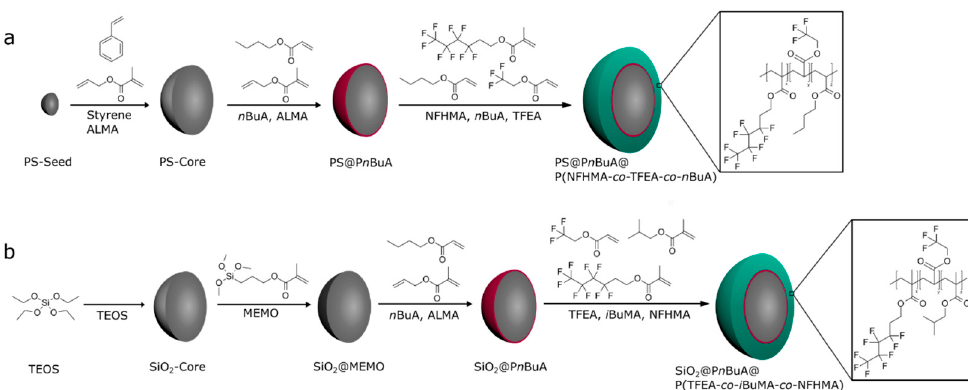
Figure 1. ( a ) Stepwise synthesis of organic fluorine-containing PS@P(NFHMA- co -TFEA- co - n BuA) core/interlayer/shell particles; ( b ) stepwise synthesis of inorganic/organic fluorine-containing core/interlayer/shell particles; ( b ) stepwise synthesis of inorganic/organic